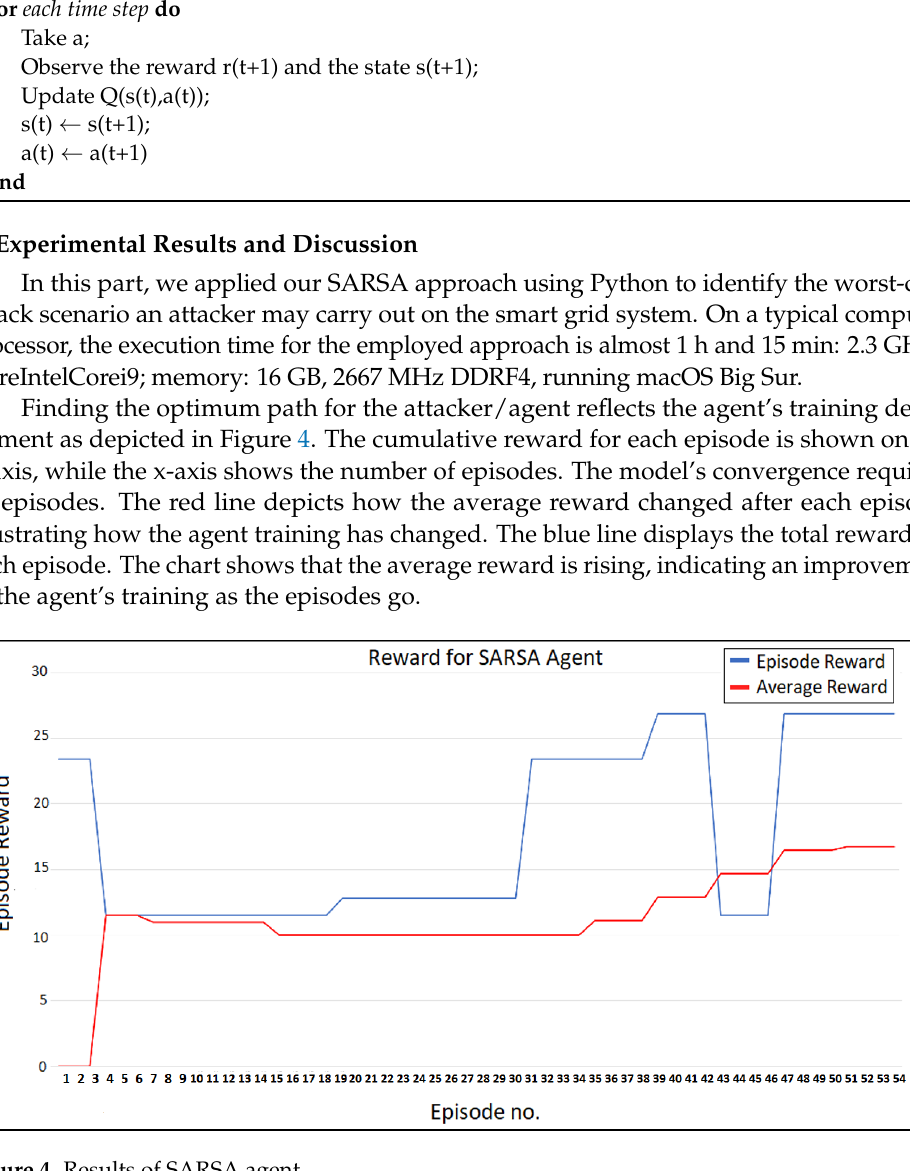
Figure 4. Results of SARSA